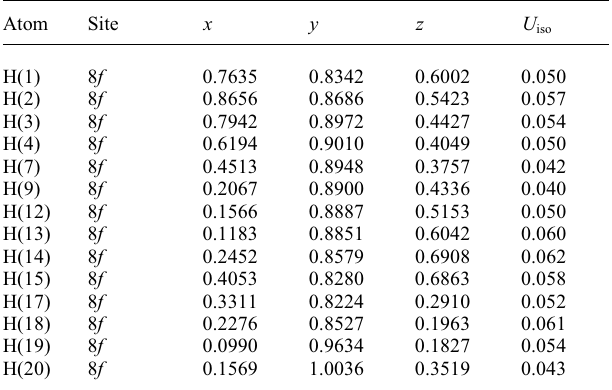
Table 2. Atomic coordinates and displacement parameters (in Å 2 )